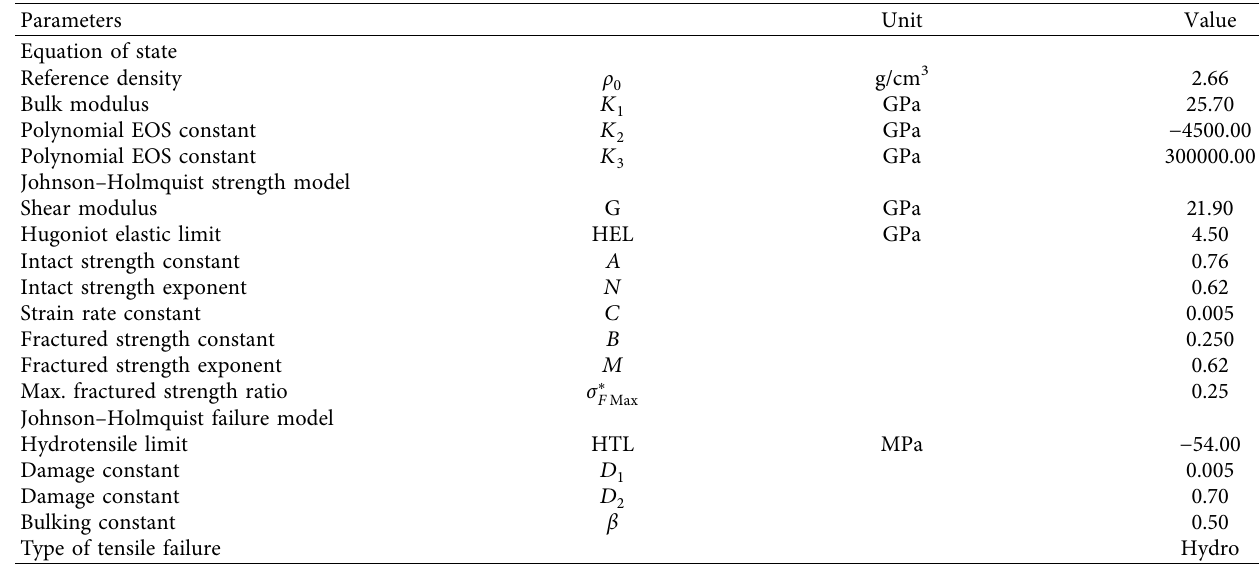
Figure 6: Schematic illustration of the JH material model: (a) strength model, (b) damage model, and (c) pressure-volume relations. Table 1: Parameters of JH constitutive model